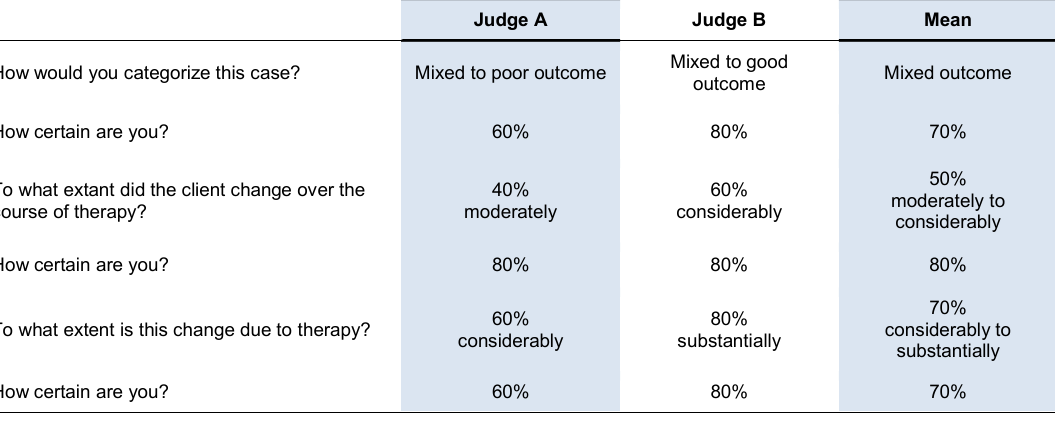
Table 6: Adjudication